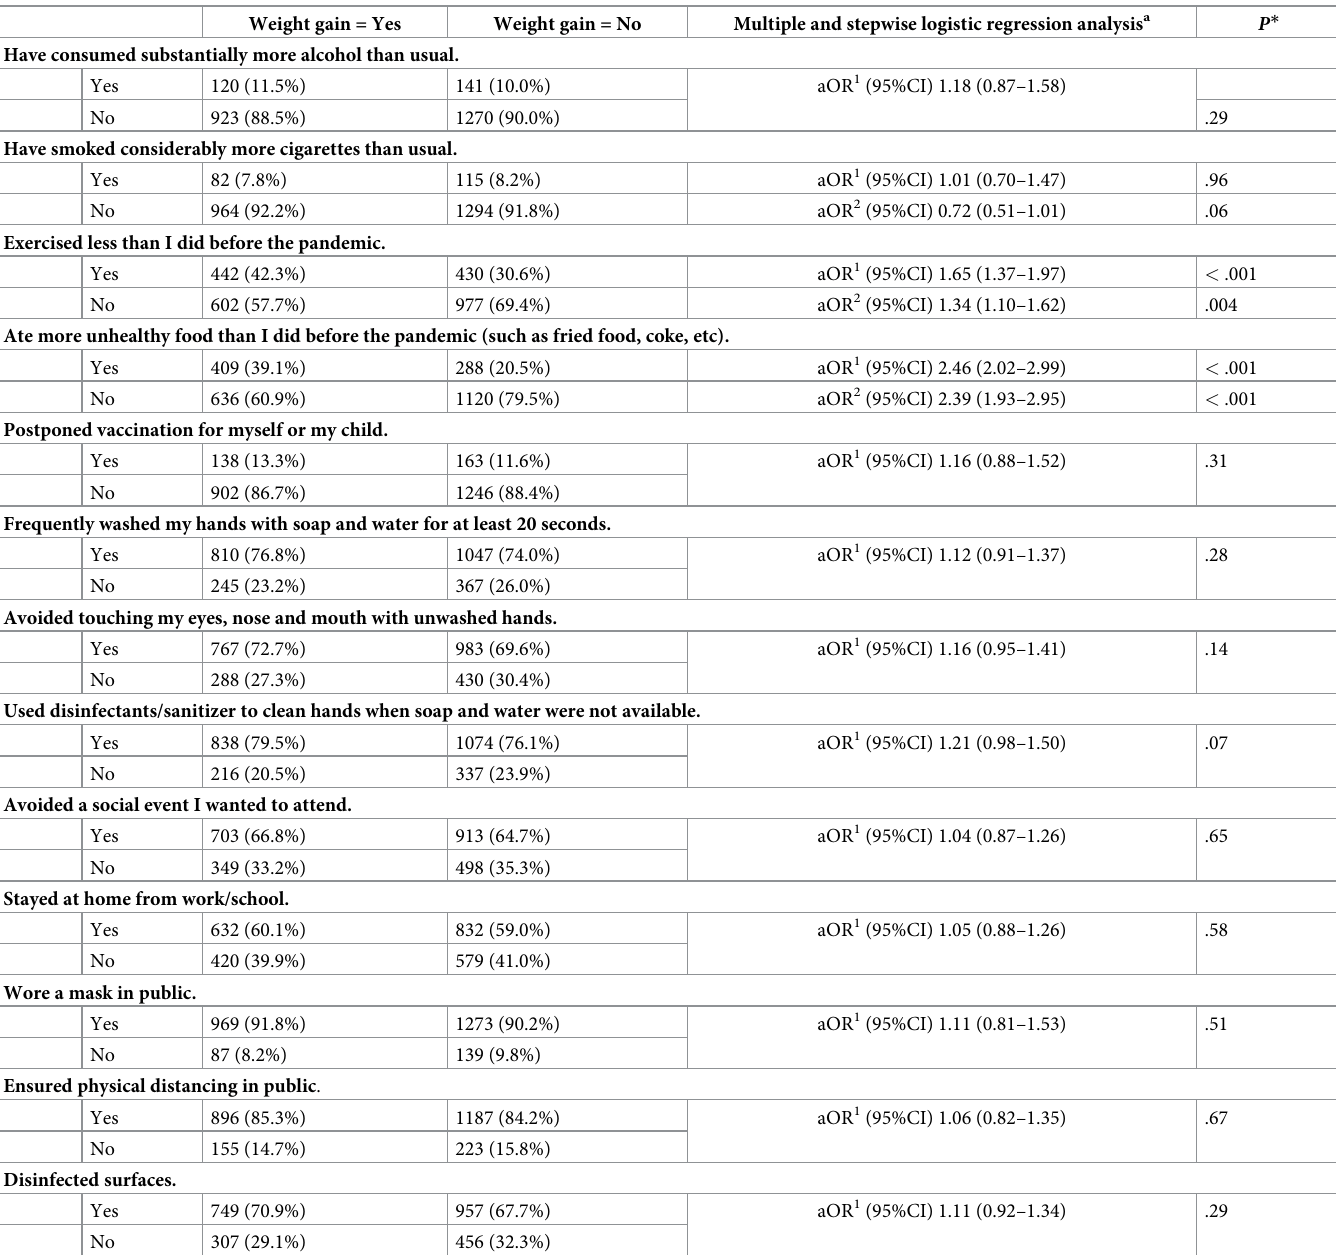
Table 4. Associations between COVID-19 related health behaviours and increased weight. Weight gain = Yes Weight gain = No Multiple and stepwise logistic regression analysis a P